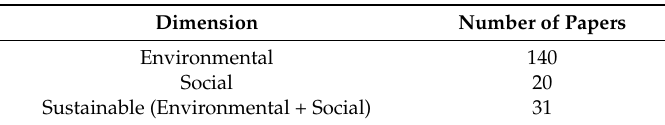
Table 1. Number of papers discussed on various dimensions